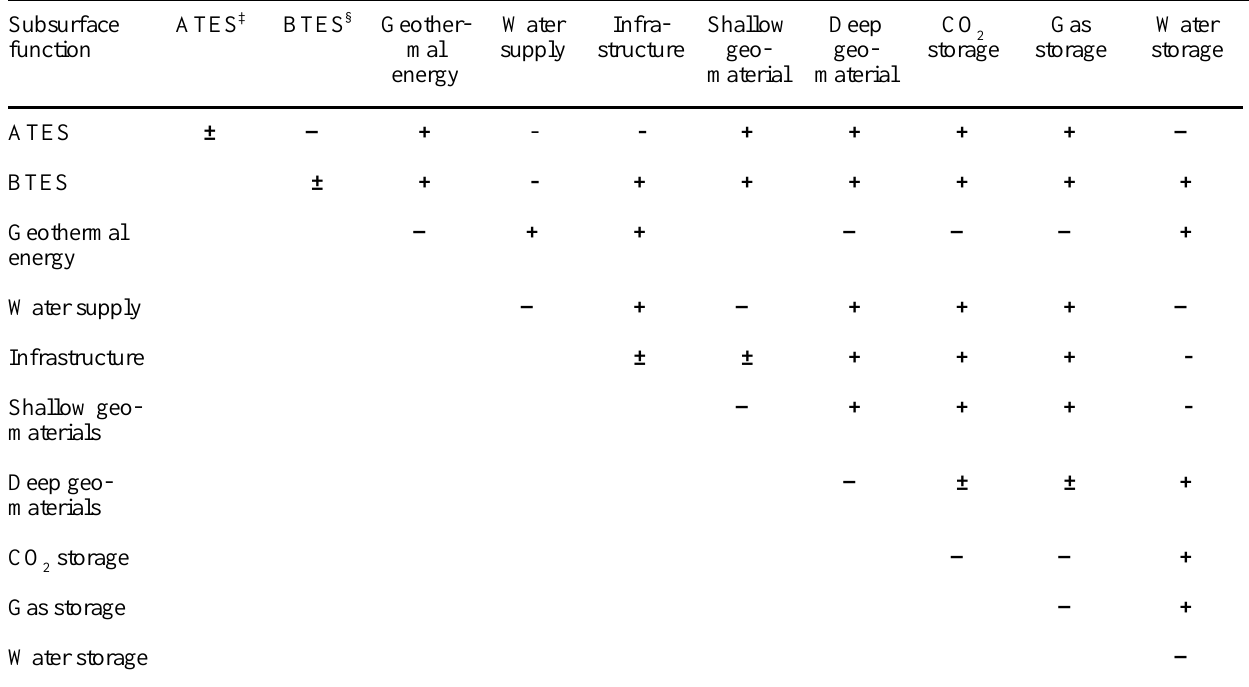
ATES ‡ BTES § Geother-